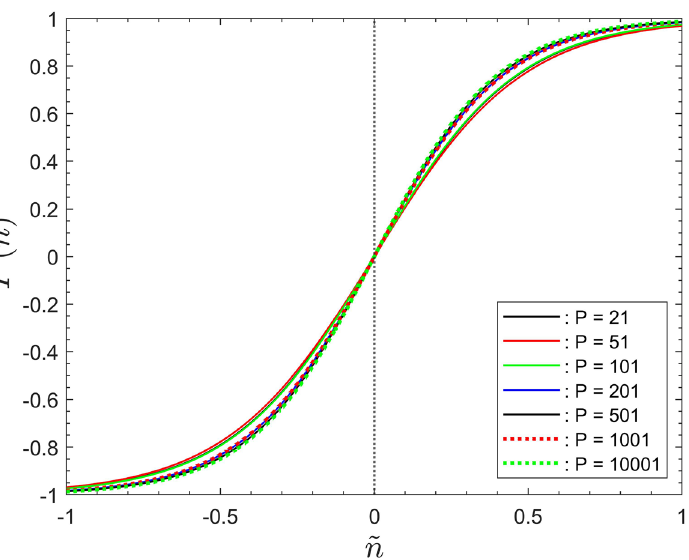
Figure 5. The data fits for the rescaled number of infected people, I ∗ as a function of the rescaled iteration step n . Data for all simulated population sizes, after equating fitting parameter β identically ˜